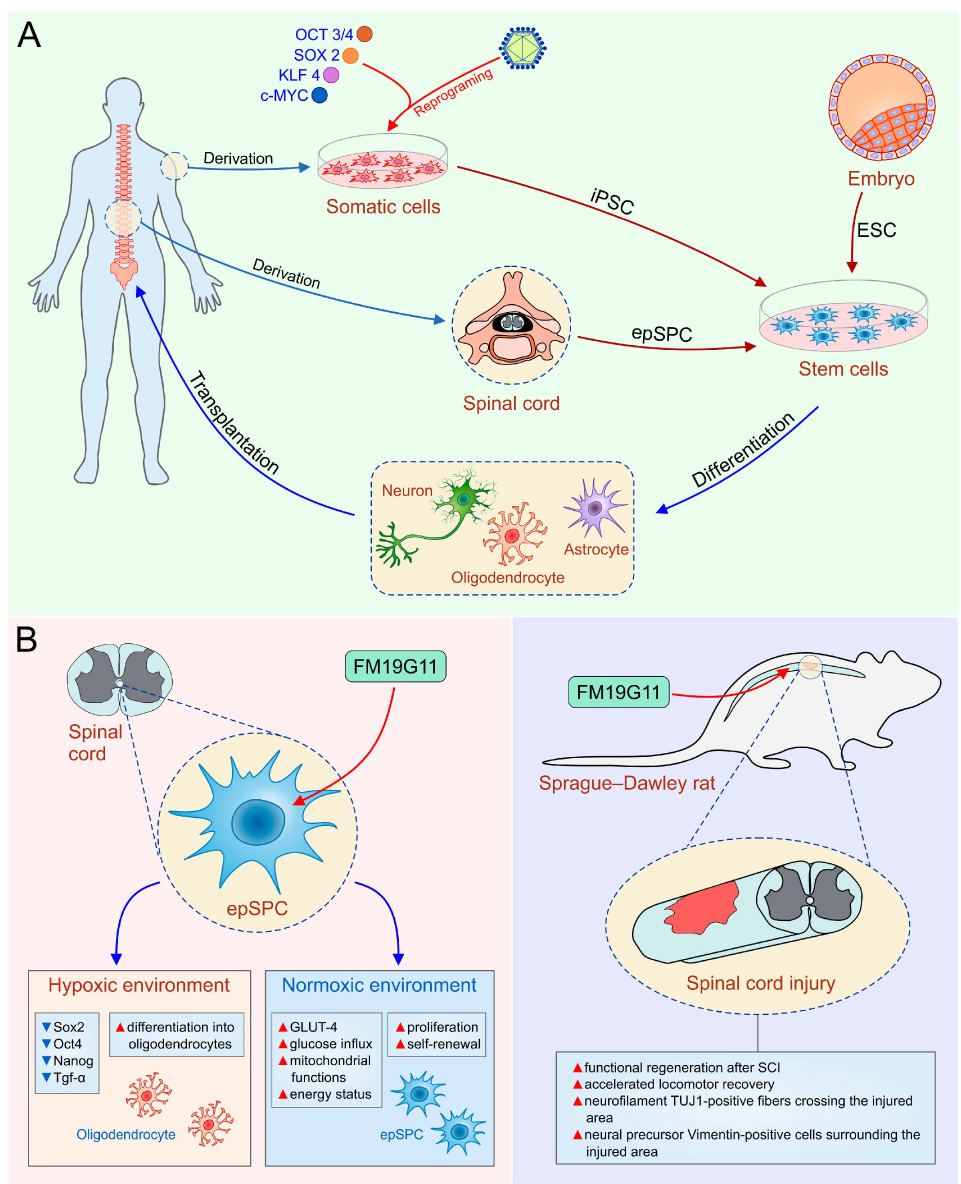
Figure 1. ( A )Human embryonic stem cells (hESC), induced pluripotent stem cells (iPSC) and ependymal stem/progenitor cells (epSPC) as a promising tool in the therapy of SCI; ( B ) the role of FM19G11, an inhibitor of hypoxia inducible factor (HIF α ), to mobilize epSPC. OCT3/4, octamer-binding transcription factor 3/4; SOX2, sex determining region Y box-containing gene 2; KLF4, Krüppel-like factor 4; TGF- α , transforming growth factor-alpha; GLUT-4, glucose transporter type